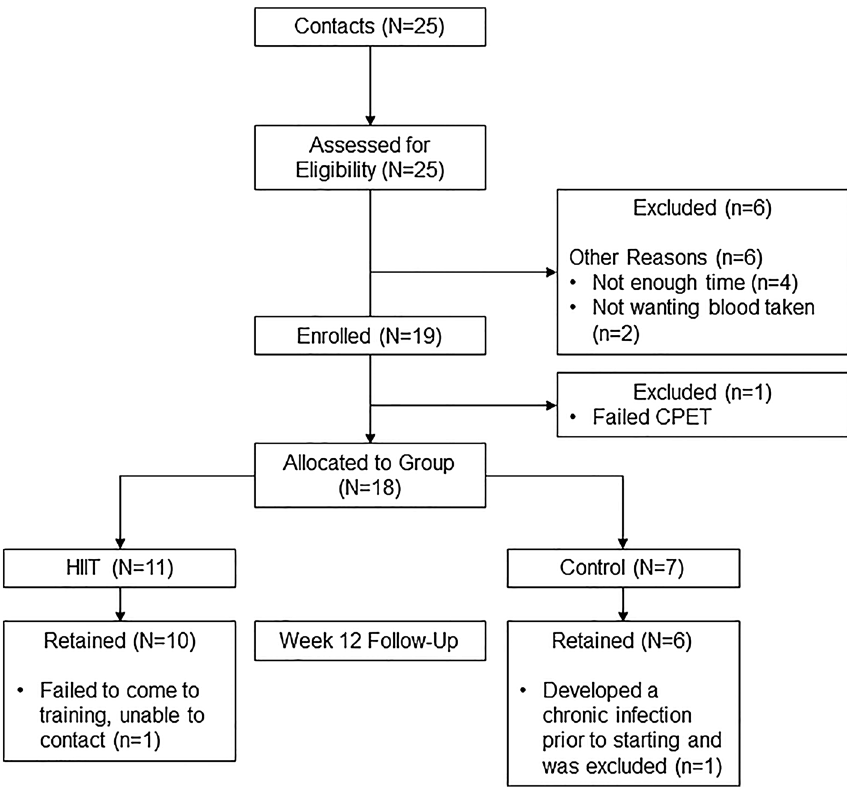
Figure 1. Consolidated standards of reporting trials (consort)